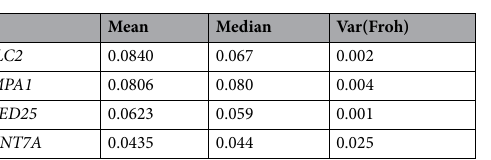
Global ancestry.